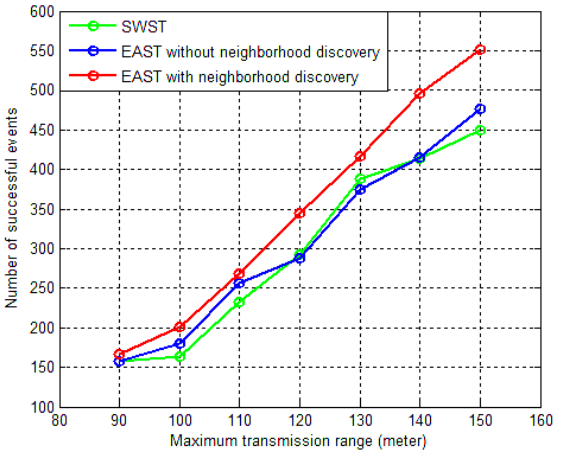
Fig. 6. Effect of the maximum transmission range over the number of successful events for SWST, EAST without neighborhood discovery and EAST with neighborhood discovery algorithms